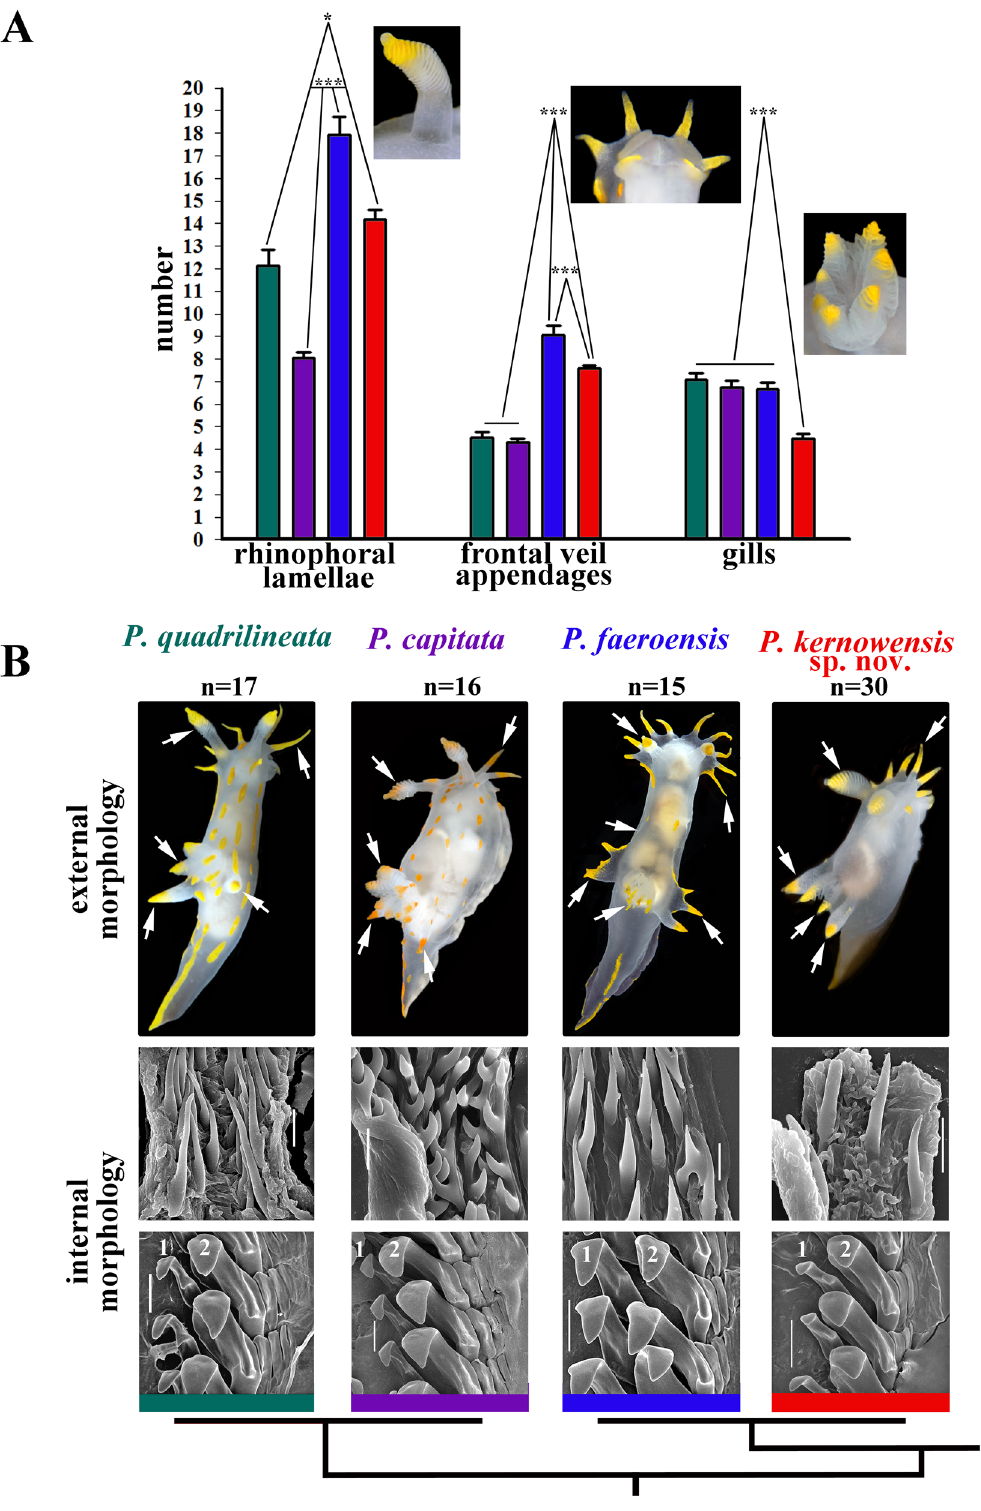
Figure 2. Statistical analysis ( A ) of the external diagnostic characters (indicated by arrows) among white and orange colour variants of detected species within European Polycera (mean ± the standard error of the mean), and presentation of the internal diagnostic features ( B ) . Scale bars: all radulae – 100 μm, all spines − 10